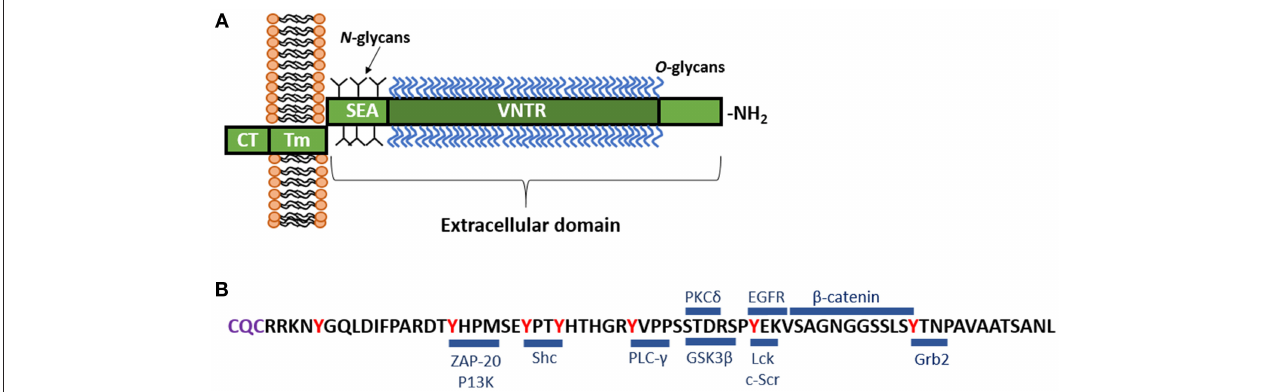
FIGURE 1 | (A) Schematic representation of MUC1. MUC1 consists of a large, extracellular, O-glycosylated polypeptide backbone that extends 200–500nm above the apical surface and consists of the variable number tandem repeat region (VNTR). The VNTR which is composed of between 25 and 125 repeats of a conserved 20 amino acid sequence. This extracellular domain is heavily 0 -glycosylated toward the N-terminal, while closer to the cell membrane, MUC1 displays N -glycans. Next to the VNTR lies the sea-urchin sperm protein, enterokinase and agrin (SEA) domain, which is non-covalently linked to the transmembrane (Tm) region and can undergo autoproteolysis in response to a range of stimuli. The Tm region, which is 28 amino acids in length, tethers MUC1 to the cell membrane. Immediately underlying the Tm region is a 72 amino acid long cytoplasmic tail (-CT), which lies inside the cell. The MUC1-CT is known to interact with multiple signaling cascades. (B) Amino acid sequence of the MUC1-CT and known binding partners. The MUC1-CT contains 7 tyrosine residues (shown in red), along with serine and threonine residues, which serve as docking sites for kinases and other adaptor proteins. Blue bars mark the known binding sites of specific cellular signaling proteins including: β -catenin ( Yamamoto et al., 1997); ZAP-70, zeta chain-associated protein kinase-70 (Li et al., 2004); P13K, phosphoinositide 3-kinase (Kato et al., 2007); Shc , Src homology 2 domain containing protein (Li et al., 2001a); PLC- γ , phospholipase C- γ (Wang et al., 2003); GSK3 β , glycogen synthase kinase 3 β (Li et al., 1998); PKC δ , protein kinase C- δ ( Ren et al., 2002); Lck , lymphocyte-specific protein tyrosine kinase (Li et al., 2004); EGFR , epidermal growth factor receptor (Li et al., 2001b); Grb2, growth factor receptor-bound protein 2 (Pandey et al., 1995). The C-terminal end of the CT contains the motif CQC (purple) which has been demonstrated to be essential for localization of MUC1 at the cell membrane (Leng et al.,